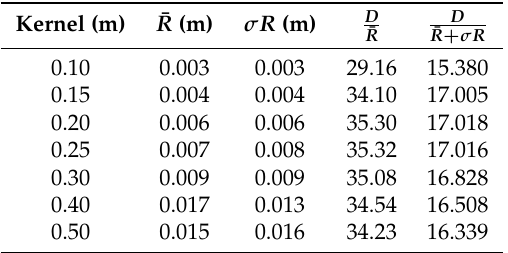
Table 1. Roughness calculations of 21 July dense point cloud.